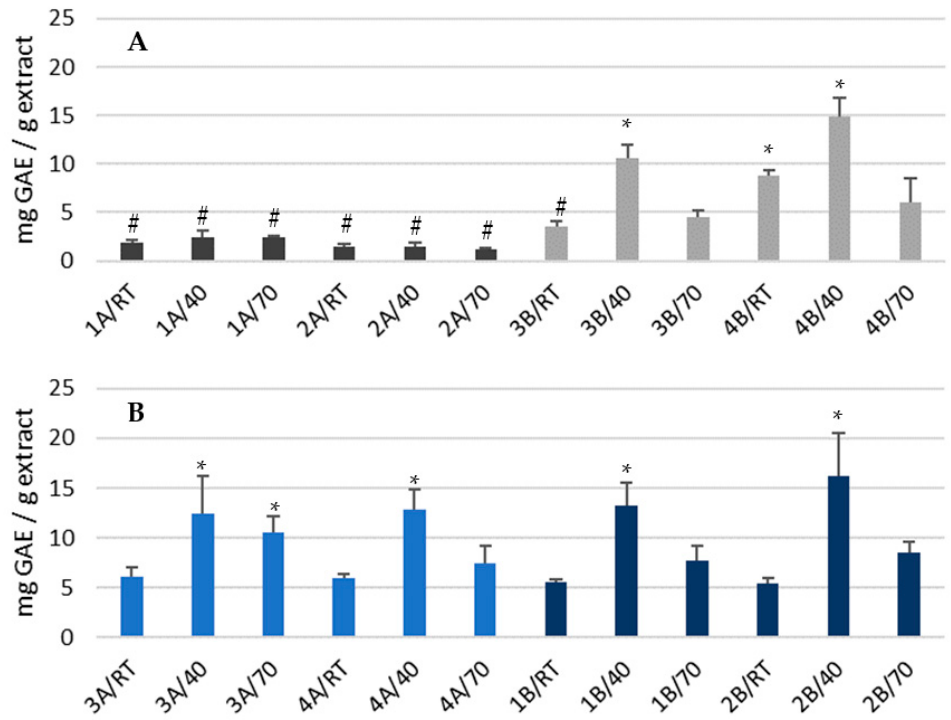
Figure 4. Quantification of total phenolic content (TPC, mg of GAE g − 1 extract) of the extracts obtained sequentially at different temperatures and using ethanol ( A ) or water ( B ) as a solvent. Values are presented as mean ± SD ( n = 4). If the values are not significantly different at 0.05 significance compared to the ones obtained from the highest value sample 4B/40, they are signaled with *; if the values are not significantly different at 0.05 significance compared to the ones obtained from the lowest value sample 2A/RT, they are signaled with #. Darker colored bars refer to the first and second extractions, with the lighter colored bars referring to the third and fourth extractions.